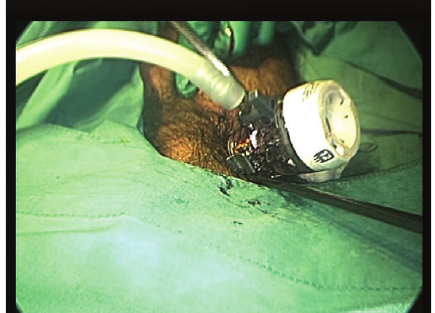
Figure 2: A photograph of the perineum. The patient is in lithotomy position and surgical drapes are applied. A 12mm laparoscopic trocar is inserted into the anus and the trocar sleeve is fully advanced until the adjustable sleeve hub was pressed against the anus, creating a seal. A straight 35 mm laparoscopic grasper can be seen sliding beside the optical trocar into the anus. The seal is maintained by pressure from the anal sphincter.